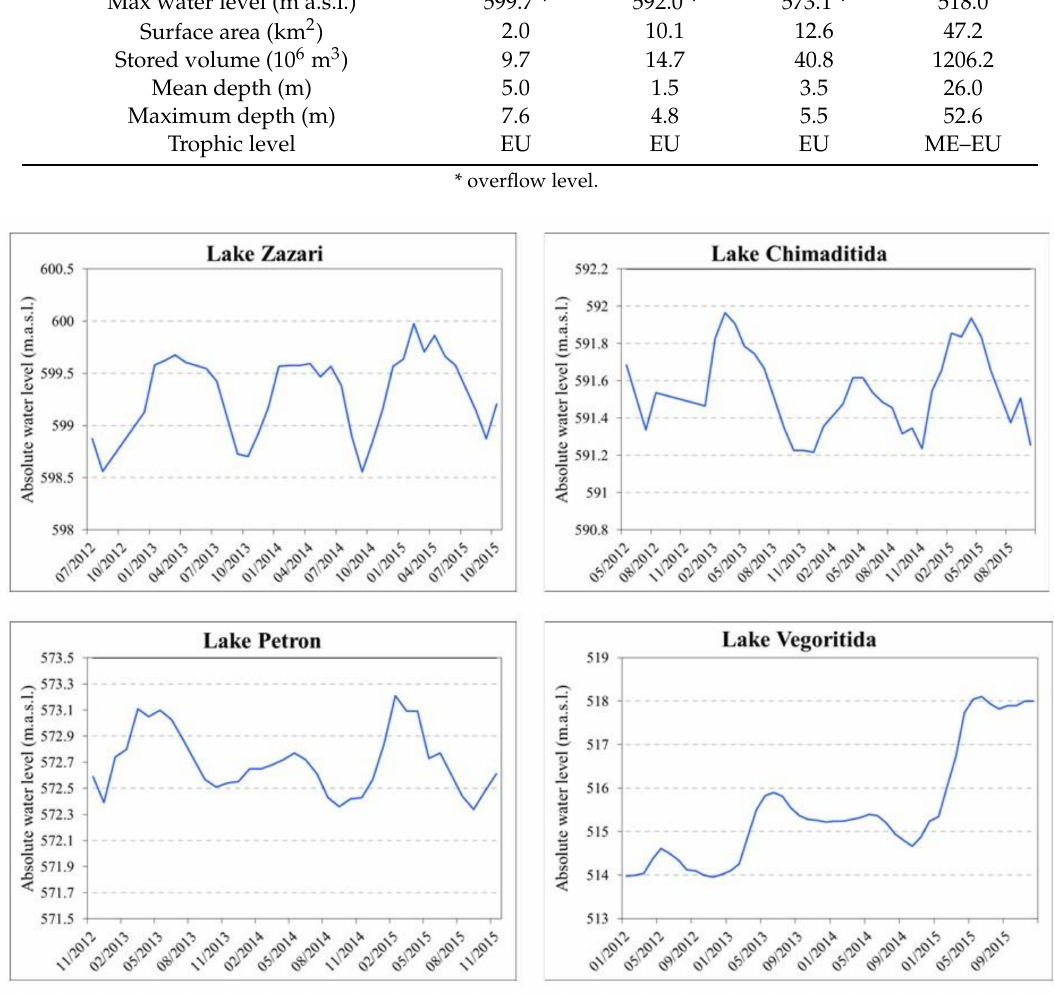
Figure 3. Water level fluctuations in lakes Zazari, Chimaditida, Petron, and Vegoritida for the period 2012–2015 (data provided by the Greek Biotope / Wetland Centre,